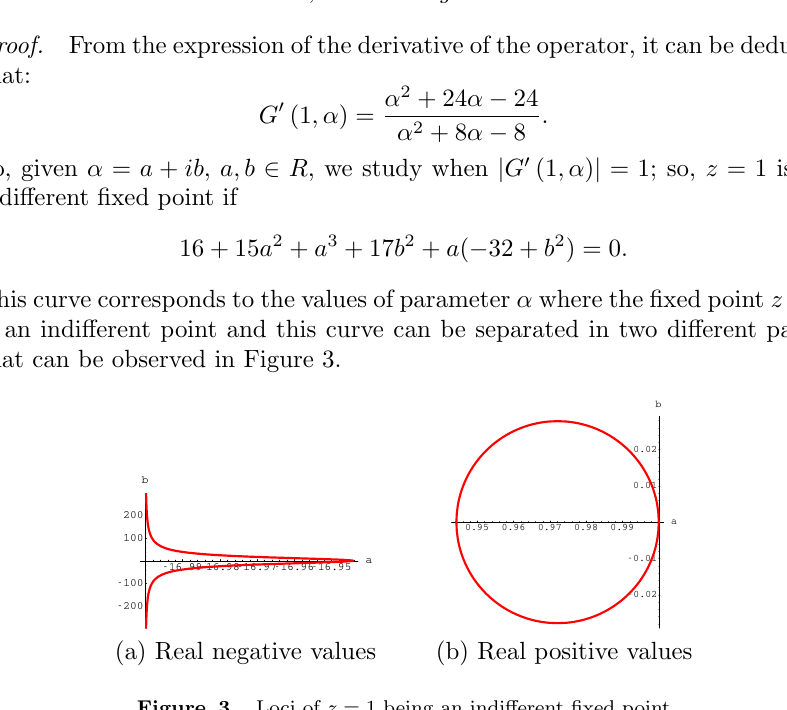
Figure 3. Loci of z = 1 being an indifferent fixed point